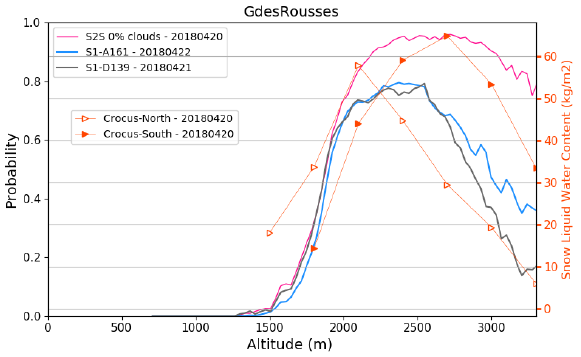
Figure 17. Same as Figure 17 but for dates close to 20 April 2018.